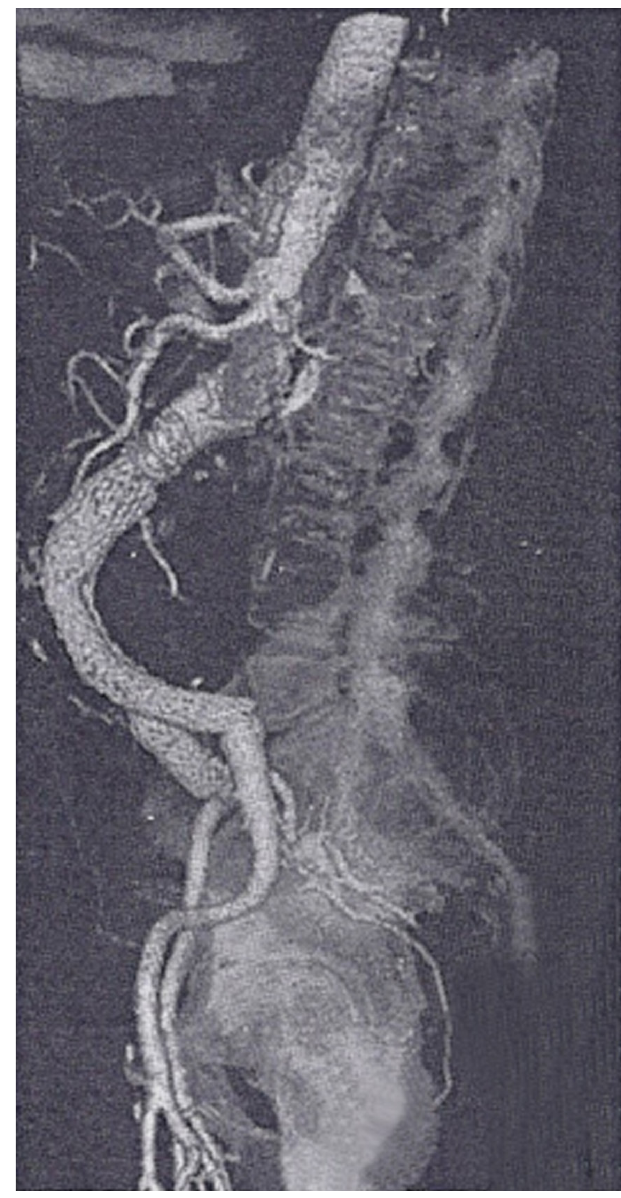
Fig. 2 – Six weeks follow-up computed tomography (CT)